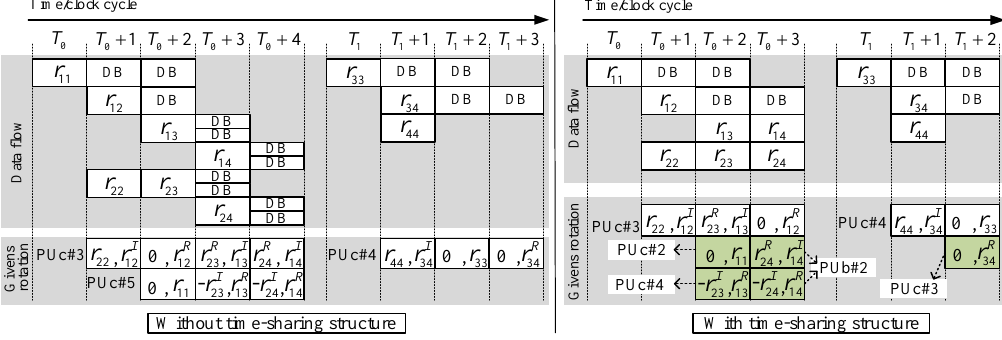
Figure 10. Processing flow of time-sharing Givens rotation structure.